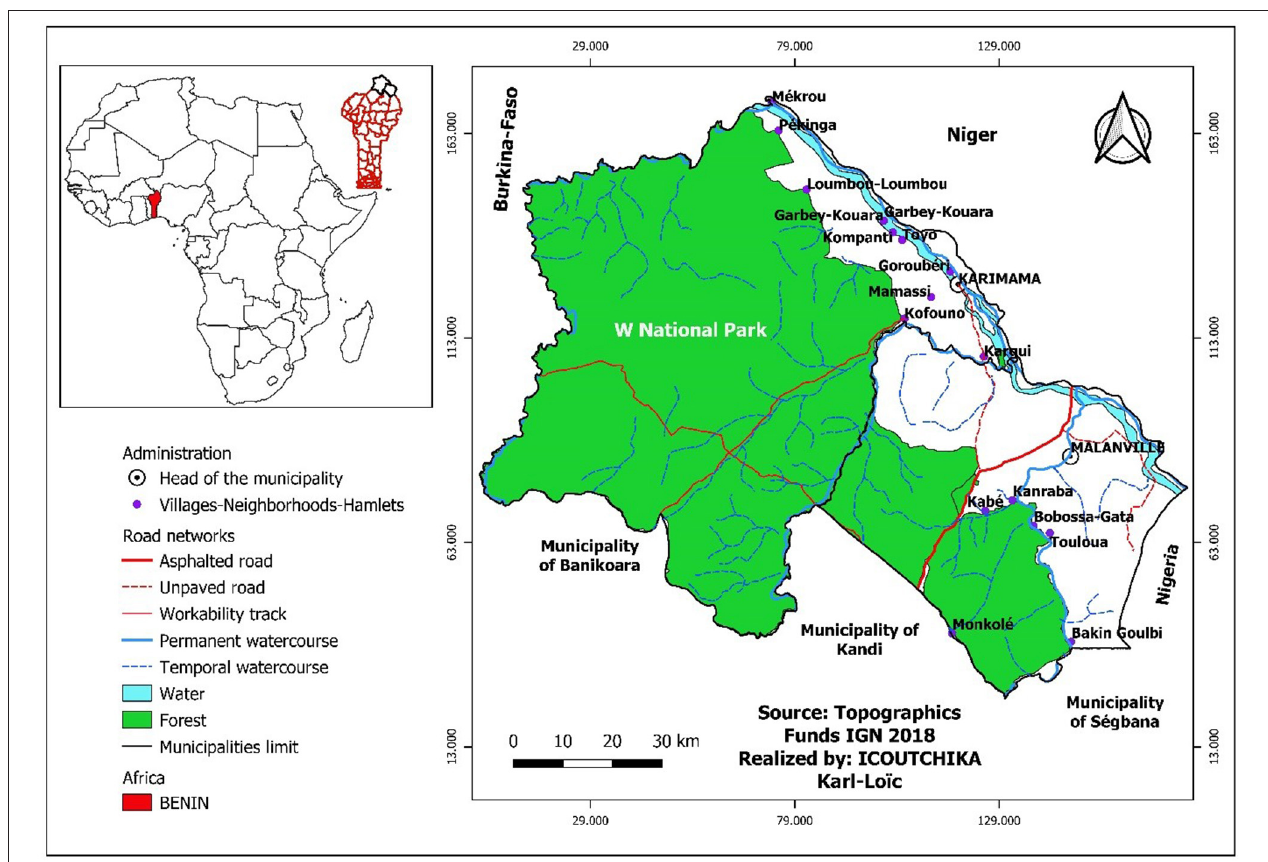
FIGURE 1 | Map showing the municipalities of Karimama and Malanville in North